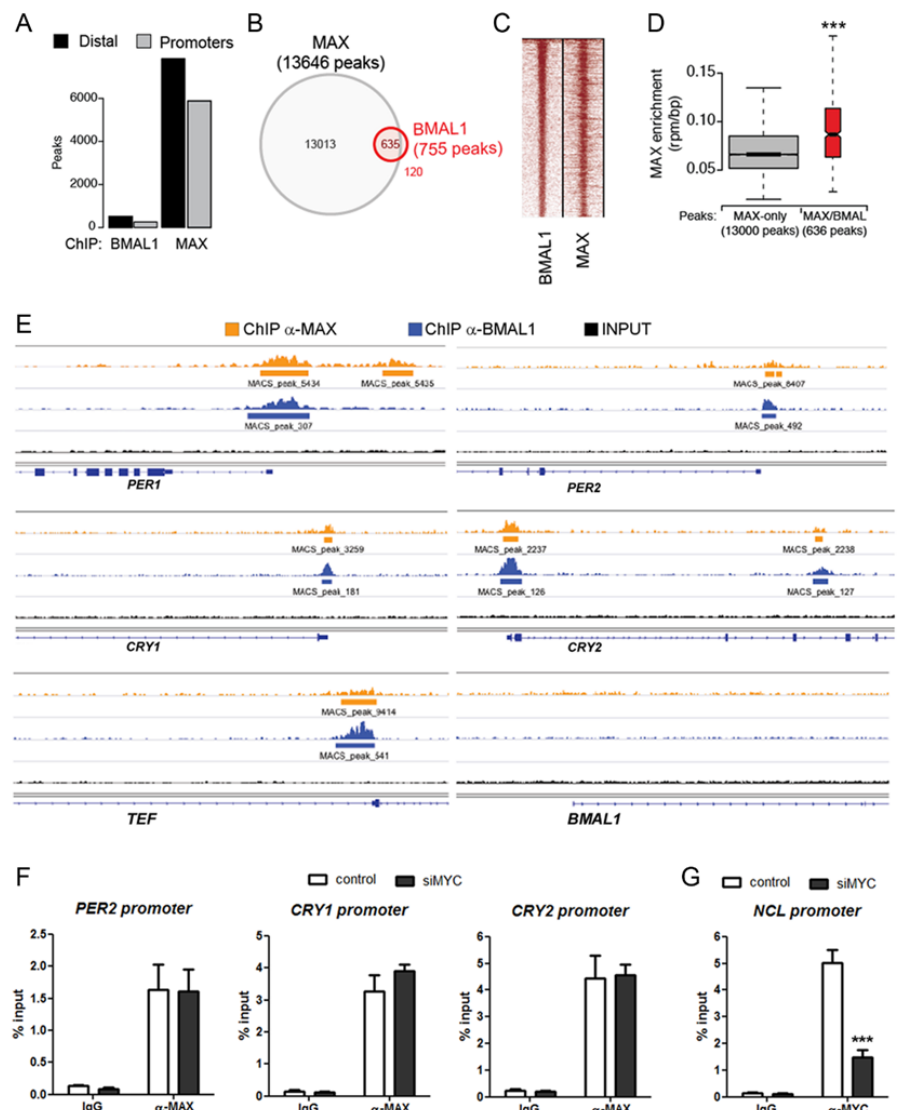
Figure 3. MAX is recruited on BMAL1-bound genomic regions. ( A ) Number of peaks identified for ChIP-seq of BMAL1 and MAX in MDA-MB-231 cells. Sub-setting of distal or promoter peaks was based on their proximity to annotated transcriptional starting site. ( B ) Venn diagram showing the overlap of ChIP-seq peaks of BMAL1 and MAX. ( C ) Heatmap of ChIP-seq signals of genomic regions co-bound by BMAL1 and MAX showing the signals for both TF factors on shared regions and their relative intensities. ( D ) Box-plot showing the enrichment of MAX in genomic regions bound by MAX (MAX only) or by both MAX and BMAL1 (MAX / BMAL1). *** p < 0.001, two-tailed Student t -test. ( E ) Genomic snapshots of the promoter region of core circadian clock genes ( PER1 , PER2 , CRY1 , CRY2 , TEF , BMAL1 ) showing the enrichment of MAX (orange) and BMAL1 (blue). Of note, all these regions contain either E-box or E’-box sequences. ( F ) Recruitment of MAX on the E-box-containing promoters of PER2, CRY1, and CRY2 in MYC-silenced and control MDA-MB-231 cells. Enrichment of MAX was evaluated by quantitative PCR of immunoprecipitated DNA compared with input DNA (% of input). Immunoglobulin G (IgG) was used as a negative control. Shown as mean + SEM, n = 3. ( G ) Chromatin samples from ( F ) were immunoprecipitated with α -MYC antibody to confirm the actual reduction of MYC recruitment on an MYC-target gene (NCL) in MYC-silenced cells. *** p < 0.001, two-tailed Student t